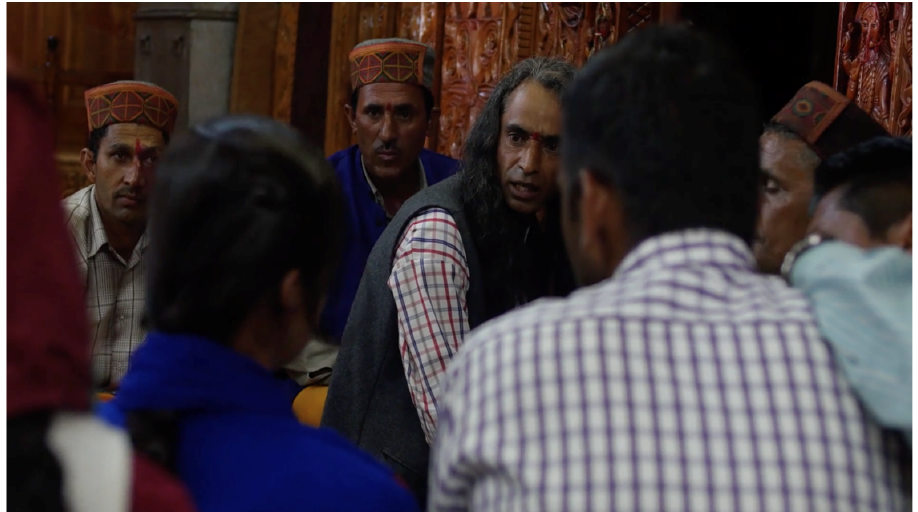
Figure 5. Exorcism at Chindi. Medium ( gur ) Jyoti Sharma (center), flanked by priests, questions a demon possessing a young in-married woman (front left). The image of the goddess is enshrined in the wooden recess to the right. Credit: Nadav Harel.